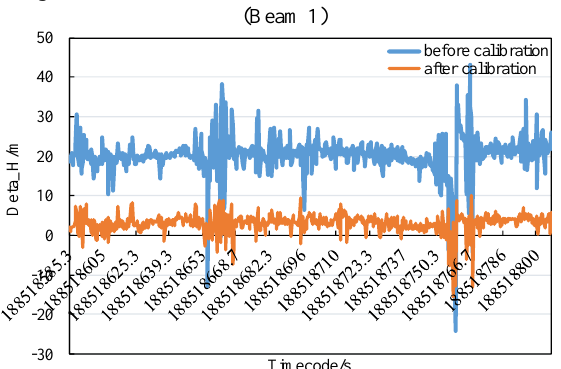
Figure 11. Elevation difference of the 755 th track laser data (Beam